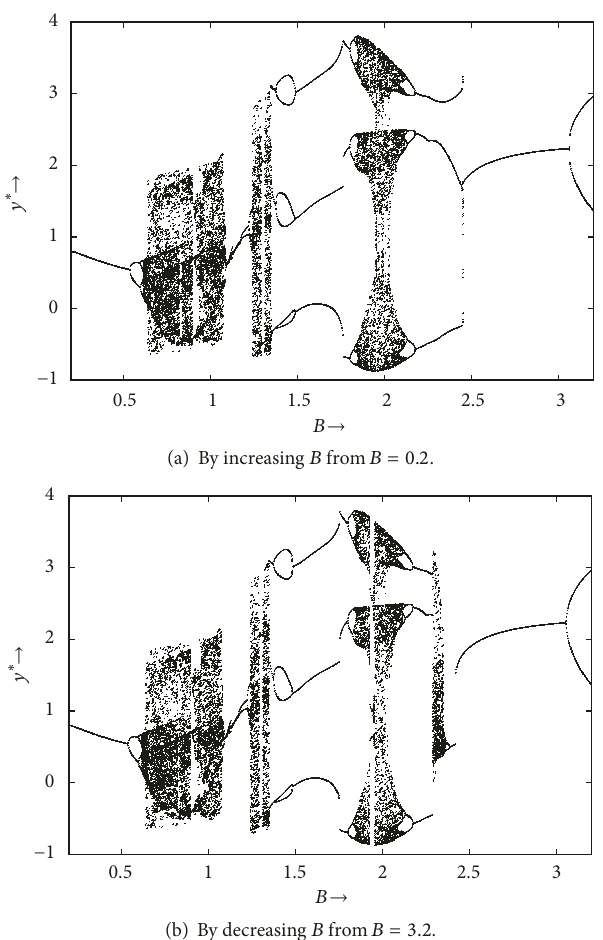
Figure 7: 1-dimensional bifurcation diagram of system (3) with (𝑦) , 𝐵 = 0.5𝜋 , and parameters (20). 𝑦 ∗ corresponds to 𝑓(𝑦) = 𝑓 2 0 the 𝑦 -coordinate of the Poincar´e